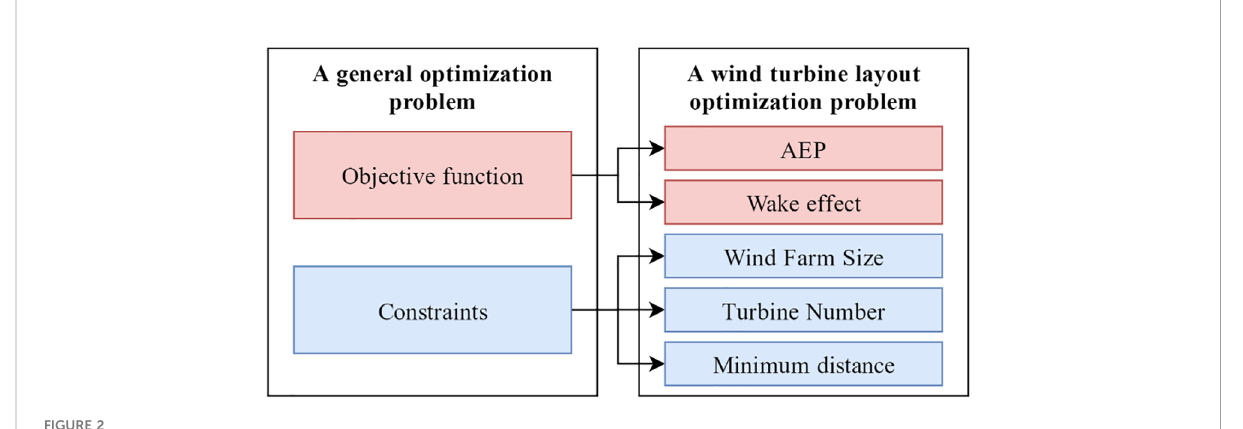
FIGURE 2 Components of a wind turbine layout optimization